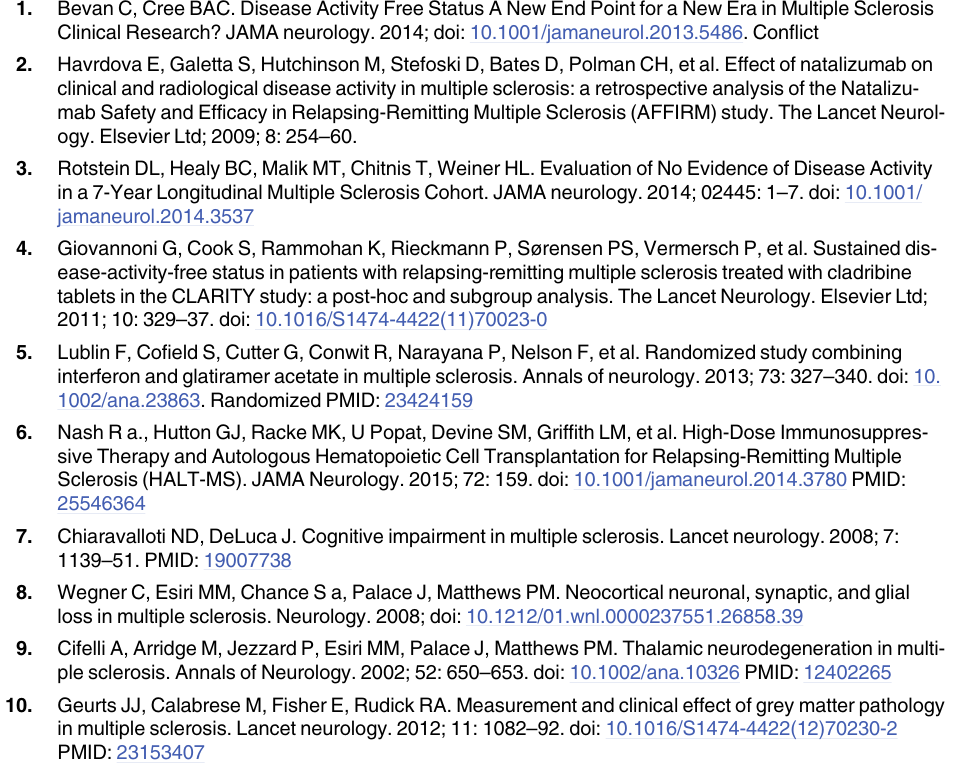
S2 Table. Disease characteristics, treatment, disease activity, fatigue, depressive symptoms and cognitive assessment of RRMS patients with clinical and MRI information at baseline and